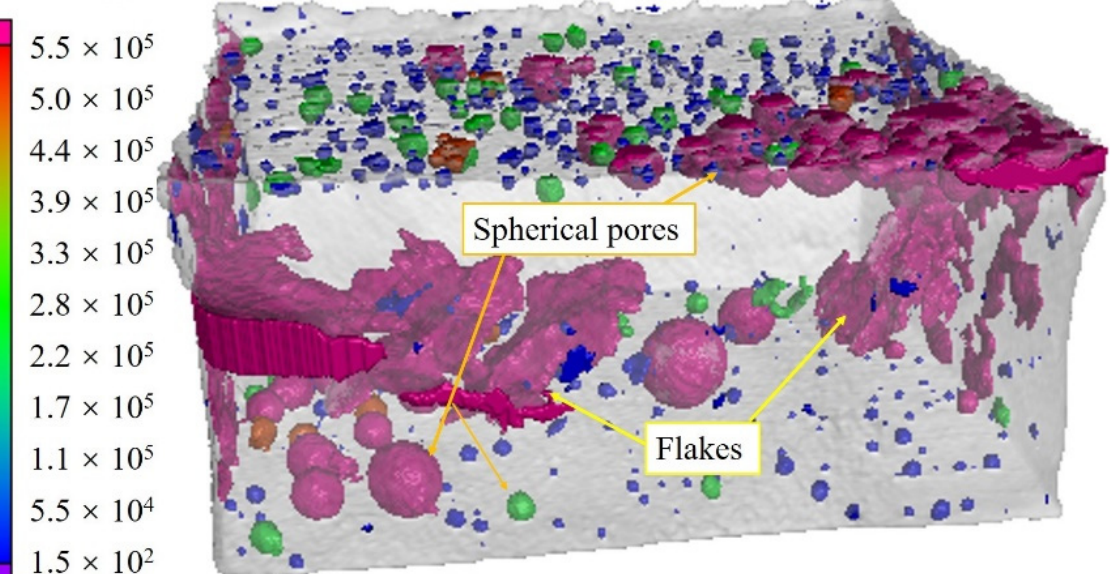
Figure 2. Reconstructed structure of defects in the Cu/SAC305/Cu solder joints.